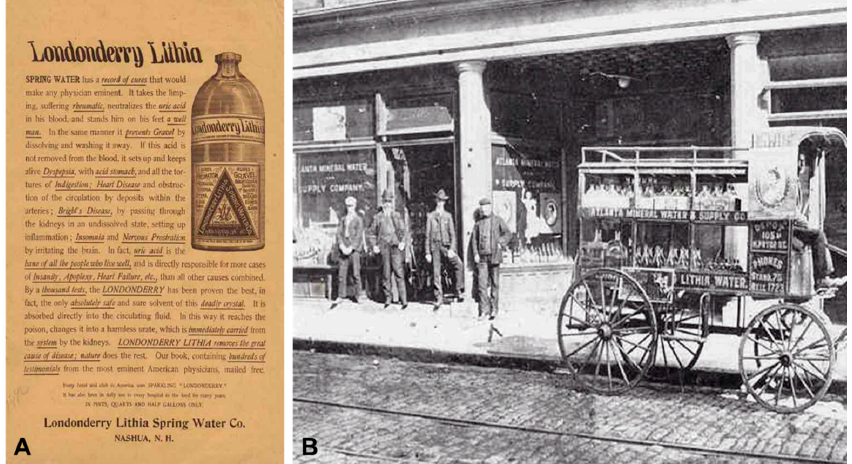
Figure 6. Two examples of the popularity of lithiated waters at the end of the 19th century: a commercial of Londonderry Lithia (Londonderry Lithia Spring Water and Co., Nashua, NH, USA), showing all its supposed therapeutic properties ( A ) and a photograph of the late 19th century of the head office and distribution system of Atlanta Mineral Water and Supply Co. (Atlanta, GA, USA) ( B ), advertising its Lithia Water.